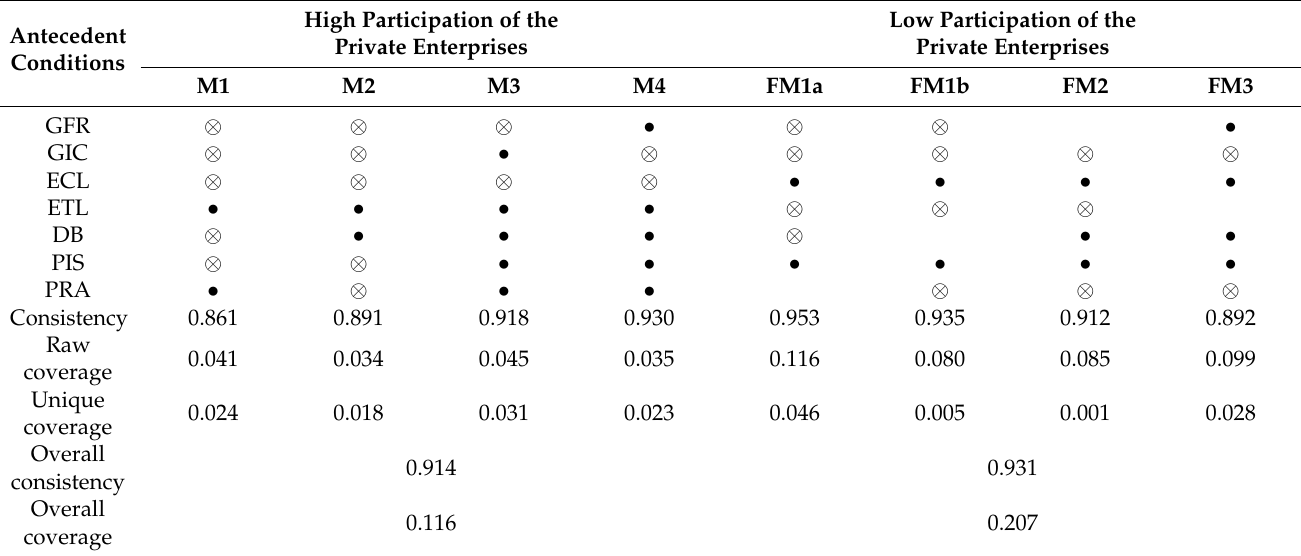
Table 4. Configuration analysis of